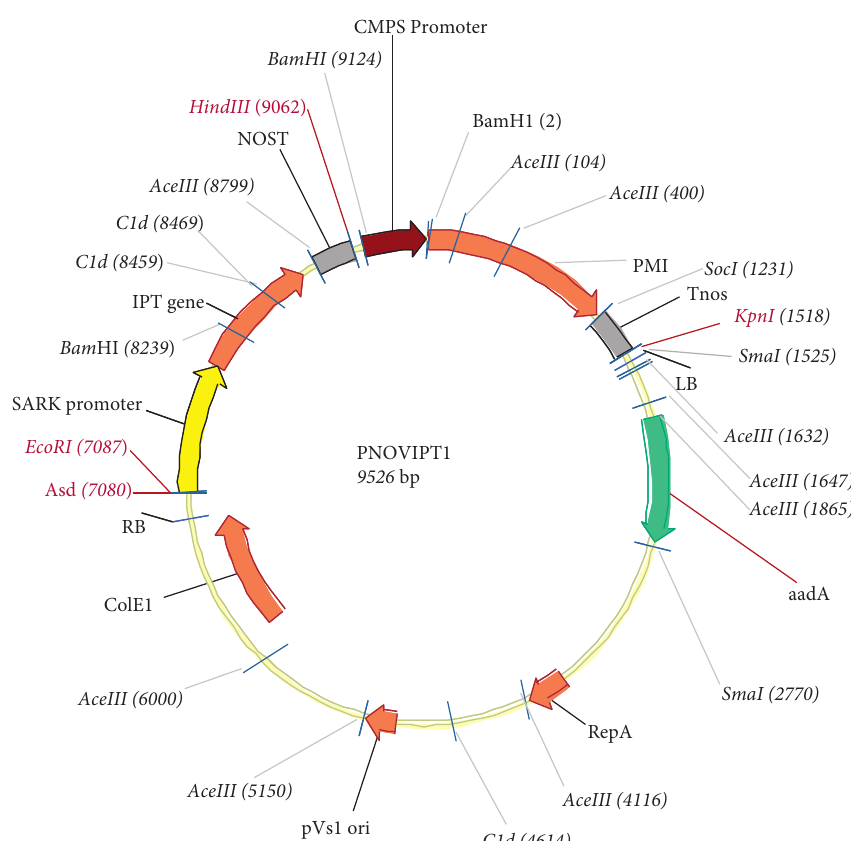
Figure 1: Gene constructs used in the study. PNOV-IPT construct carrying the P phosphomannose isomerase gene; NOST: nopaline synthase terminator; LB: left border; RB: right